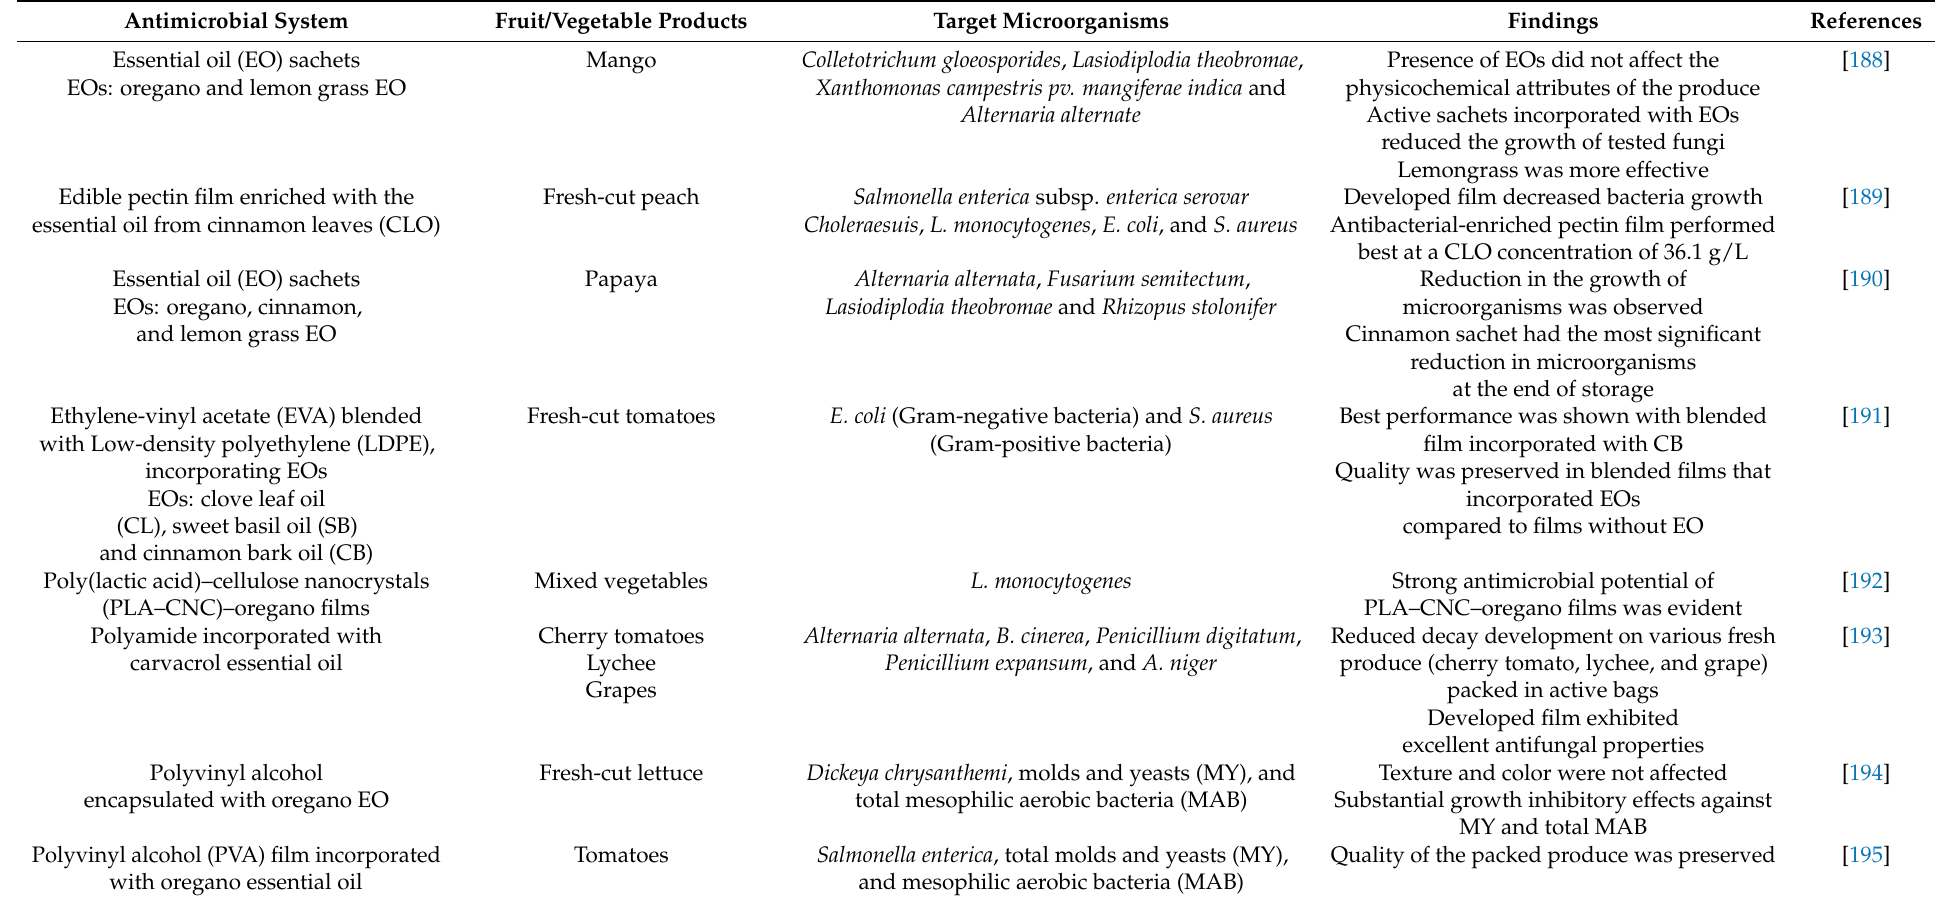
Table 4. Summary of examples of antimicrobial packaging systems utilized to reduce microbial growth in fruit and